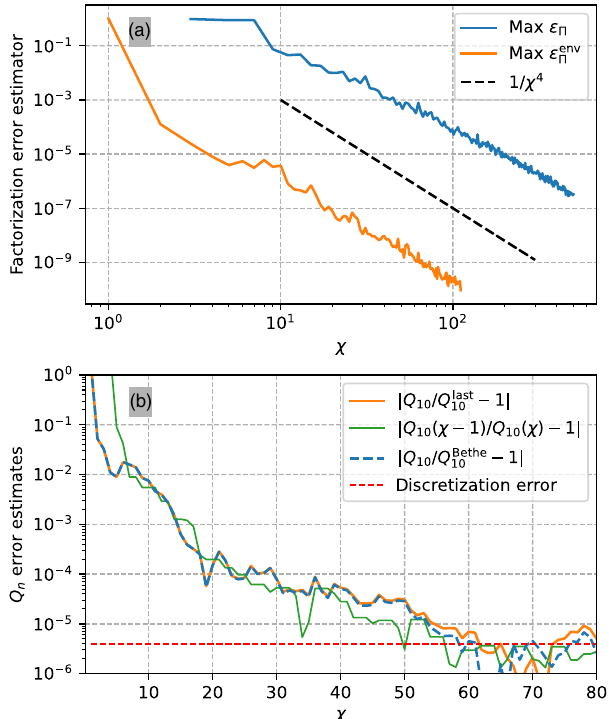
FIG. 7. (a) Upper: factorization error estimator as a function of 0 , the tensor rank χ , for the SIAM model, for n ¼ 10 , ϵ d ¼ 15 , Gauss-Kronrod points with 63 points, using the error t M ¼ functions ϵ env Π (orange curve) and ϵ Π (blue curve); see the text. (b) Lower: error of the integral Q versus χ , measured using n different estimators. In this case, Q last 10 is Q 10 for χ ¼ 100 . The red line is the error due to the integral discretization obtained by varying the number of integration points.